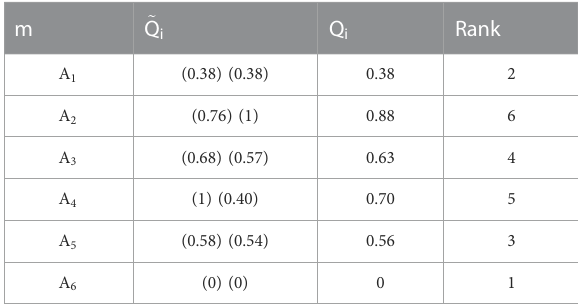
TABLE 10 Rating of Q i and rank of each alternative.